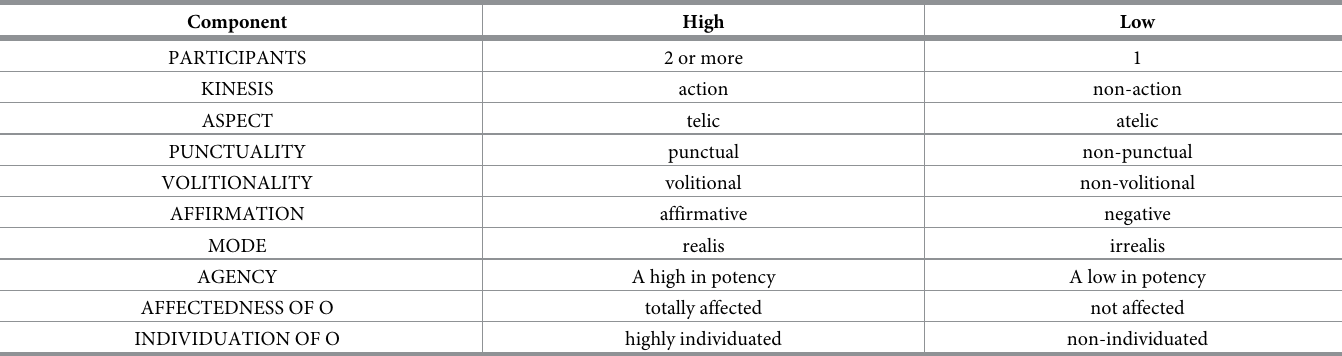
Table 1. Hopper and Thompson’s Transitivity parameters.